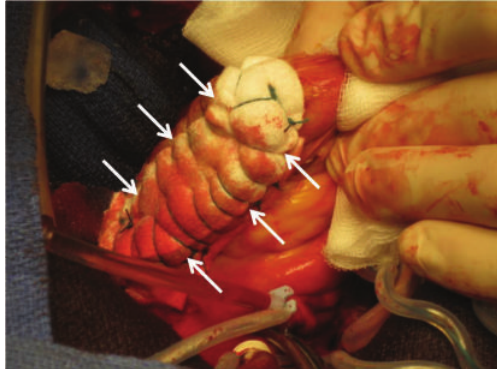
Figure 2: Arrows delimit the insertion of the felt patch used for the closure of the left-ventricle